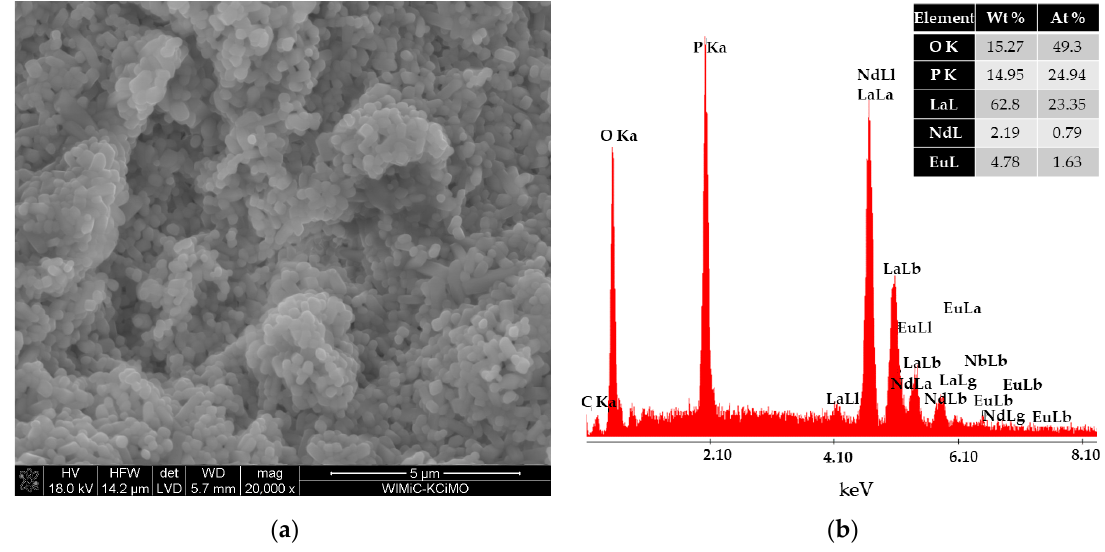
Figure 2. SEM image of LaPO 4 :Eu 3+ /Nd 3+ with magnification 20,000× ( a ) and analysis of the chemical composition of the LaPO 4 :Eu 3+ /Nd 3+ sample ( b ).